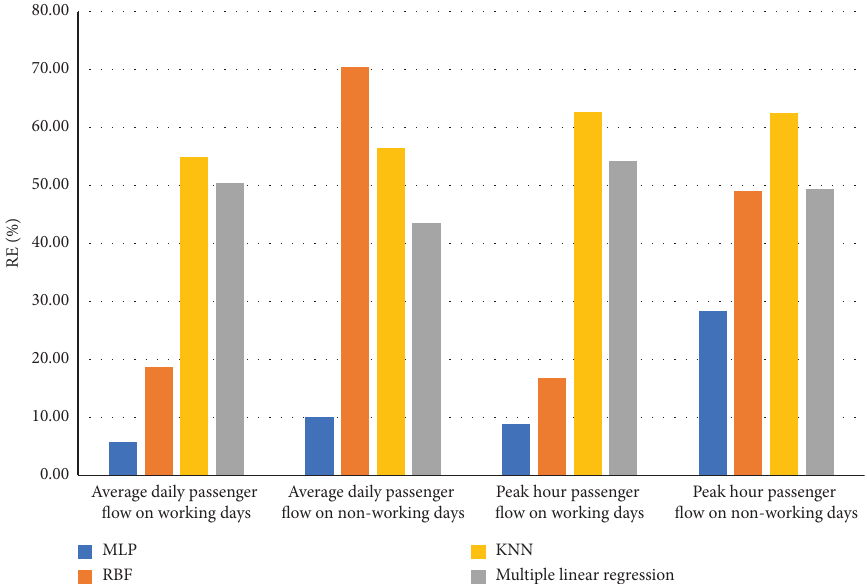
Figure 17: Comparison of prediction results of Wangjing station.